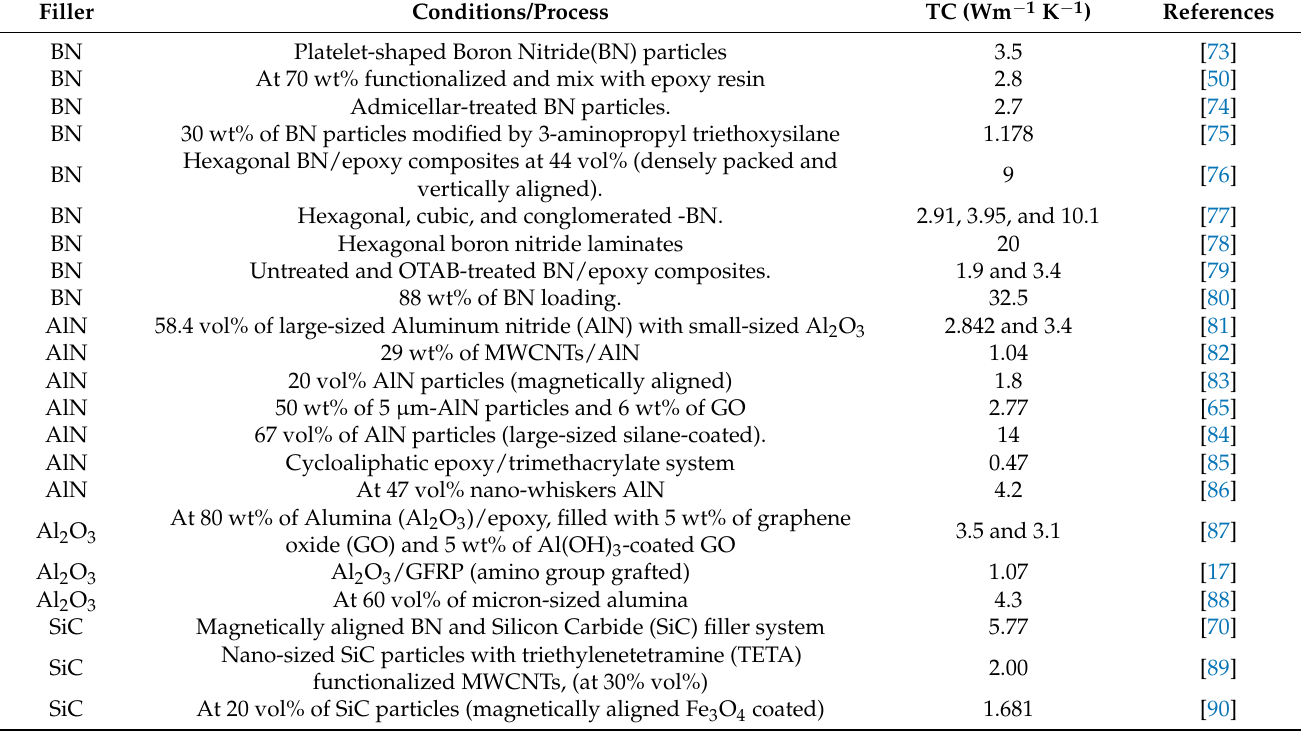
Table 2. Summary of the recently published works on ceramic